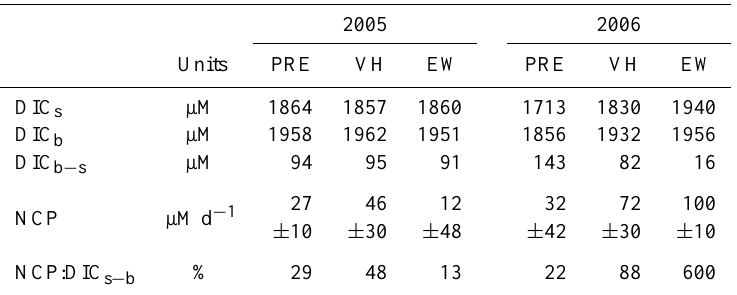
Table 3. Surface and bottom DIC (DIC s and DIC b ) , difference between DIC s and DIC b (DIC b − s ) , surface net community production (NCP) in the mixed layer (note that unit of NCP was converted to µMd − 1 ) , and NCP: DIC b − s ratios (%) in summer during 2005 and 2006,